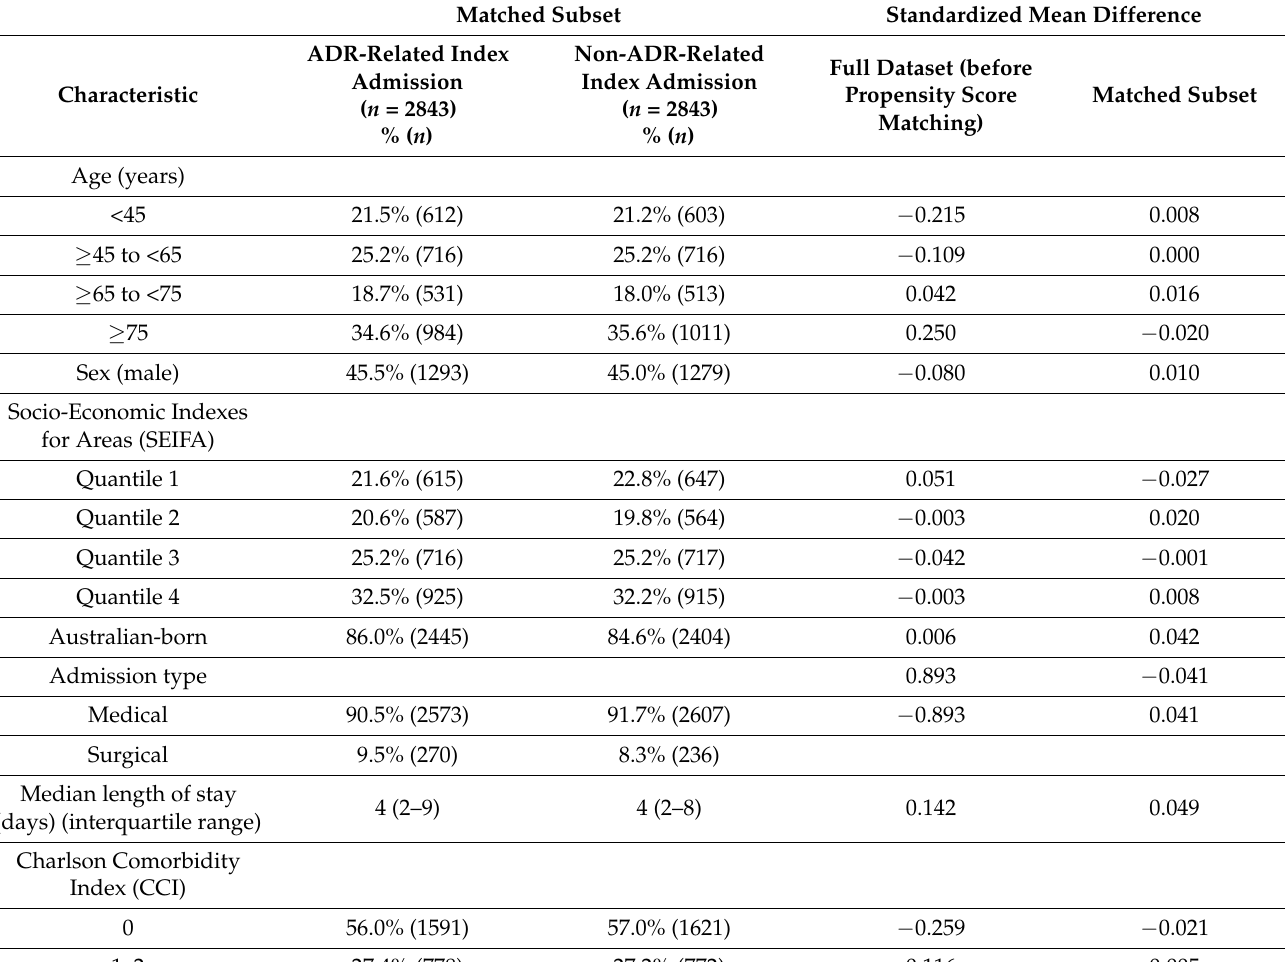
Table 2. Patient characteristics at baseline in propensity-matched